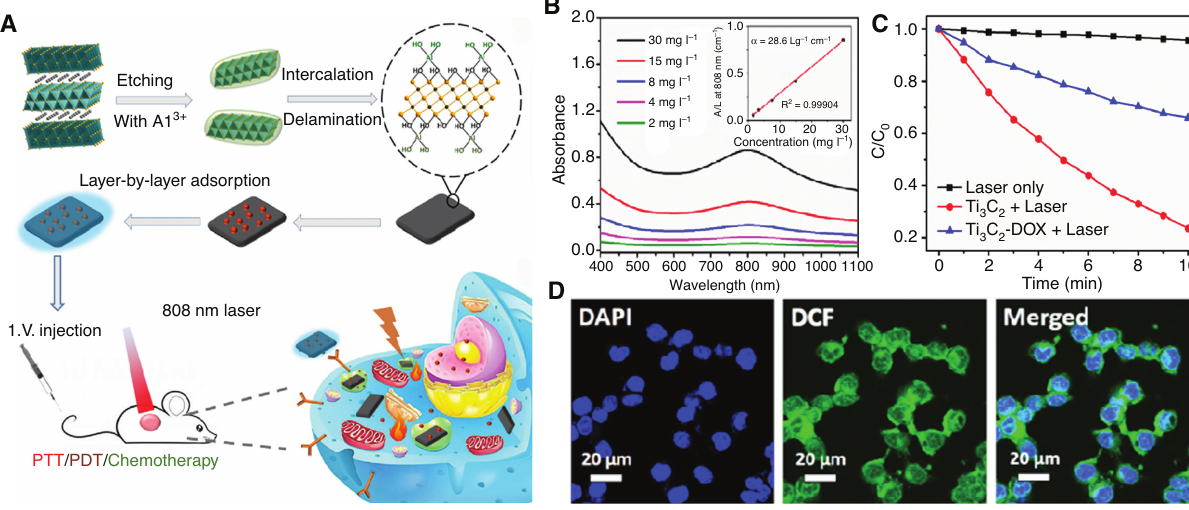
Figure 6: PDT of cancer. (A) Schematic illustration of the preparation of Ti nanoplatelets dispersed in water at various concentrations. Inset: Absorbance plot of Lambert-Beer’s law at 808 nm [95]. (C) Normalized absorbance of DPBF in the presence of Ti